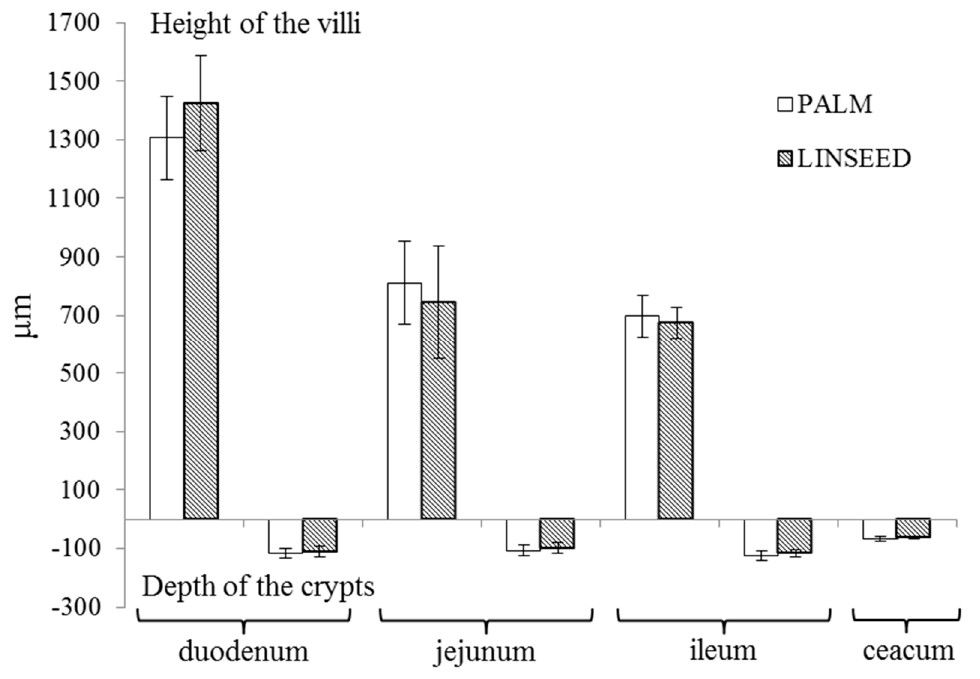
Figure 2. Height of the villi and depth of the crypts in individual parts of the intestine. On the abscissa are different parts of the small intestine: duodenum, jejunum, ileum, and ceacum, on the ordinate is the length in μ m, in positive way the height of v the villi and in negative way the depth of the crypt, PALM: 6% palm fat in a diet and LINSEED: 6% linseed oil in a diet.